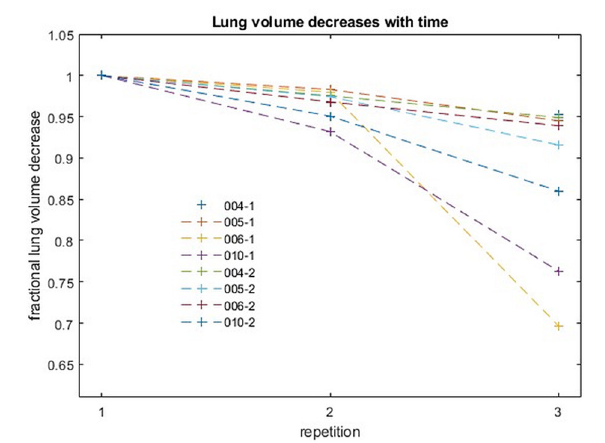
performed with an interruption of a few seconds for restarting the MR sequence.